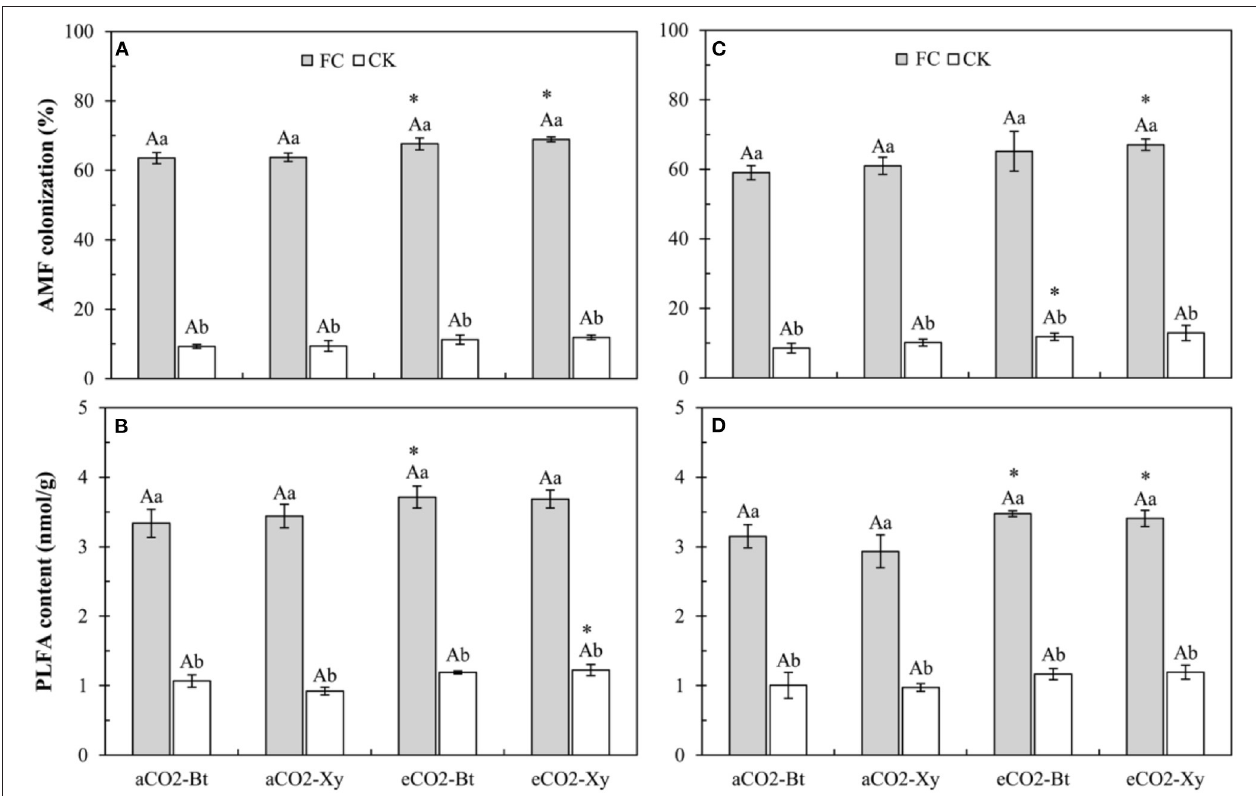
FIGURE 1 | Effects of the inoculation with arbuscular mycorrhizal fungi (AMF), F. caledonium, on the AMF colonization and AMF-PLFA content of Bt maize (Bt) and its parental line of non- Bt maize (Xy) under ambient CO 2 ( a CO 2 ) and elevated CO 2 ( e CO 2 ) at the heading stage (BBCH-59) in 2017 (A,B) and 2018 (C,D) . (FC, F. caledonium inoculation; CK, the control without F. caledonium inoculation; a CO 2 -Bt, Bt maize under a CO 2 ; a CO 2 -Xy, non- Bt maize under a CO 2 ; e CO 2 -Bt, Bt maize under e CO 2 ; e CO 2 -Xy, non- Bt maize under e CO 2 ; different uppercase, lowercase letters, and * indicate significant difference between Bt maize and non- Bt maize, between F. caledonium inoculation and non-inoculation of F. caledonium, and between a CO 2 and e CO 2 under the same other conditions as revealed by Tukey’s test) ( P < 0.05; n =